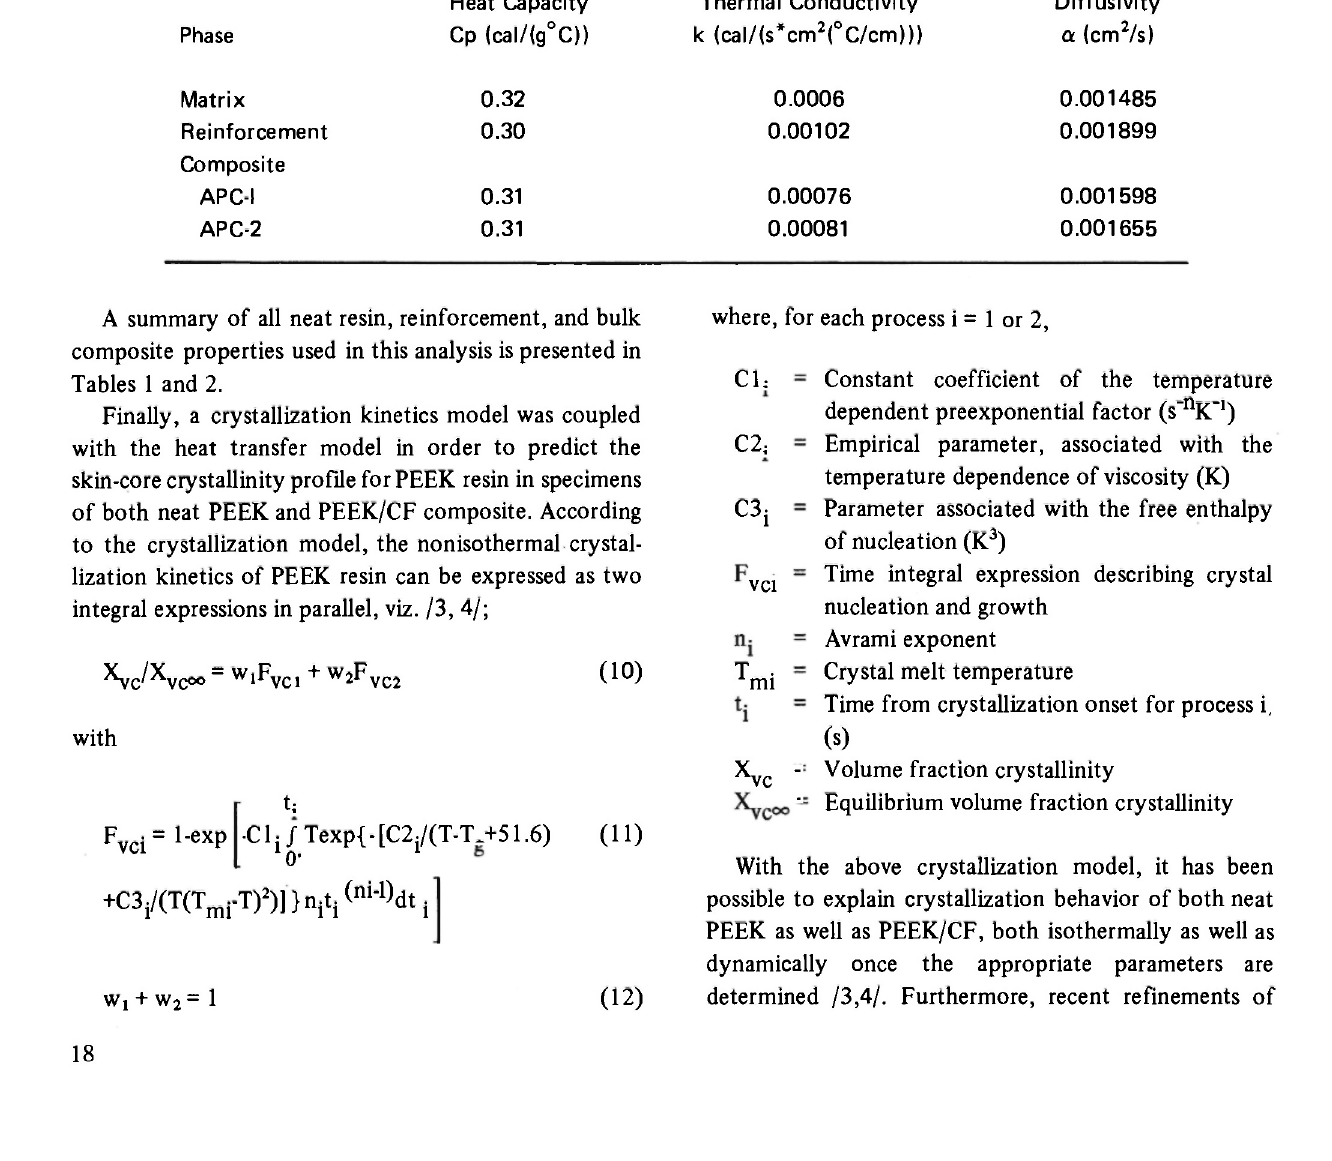
TABLE 2: Constituent Phase and Composite Properties of Carbon Fiber Reinforced